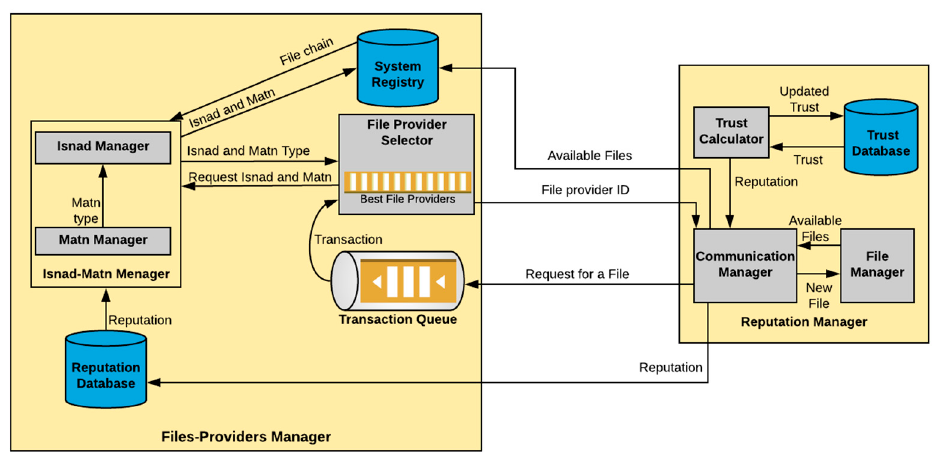
Figure 1. System